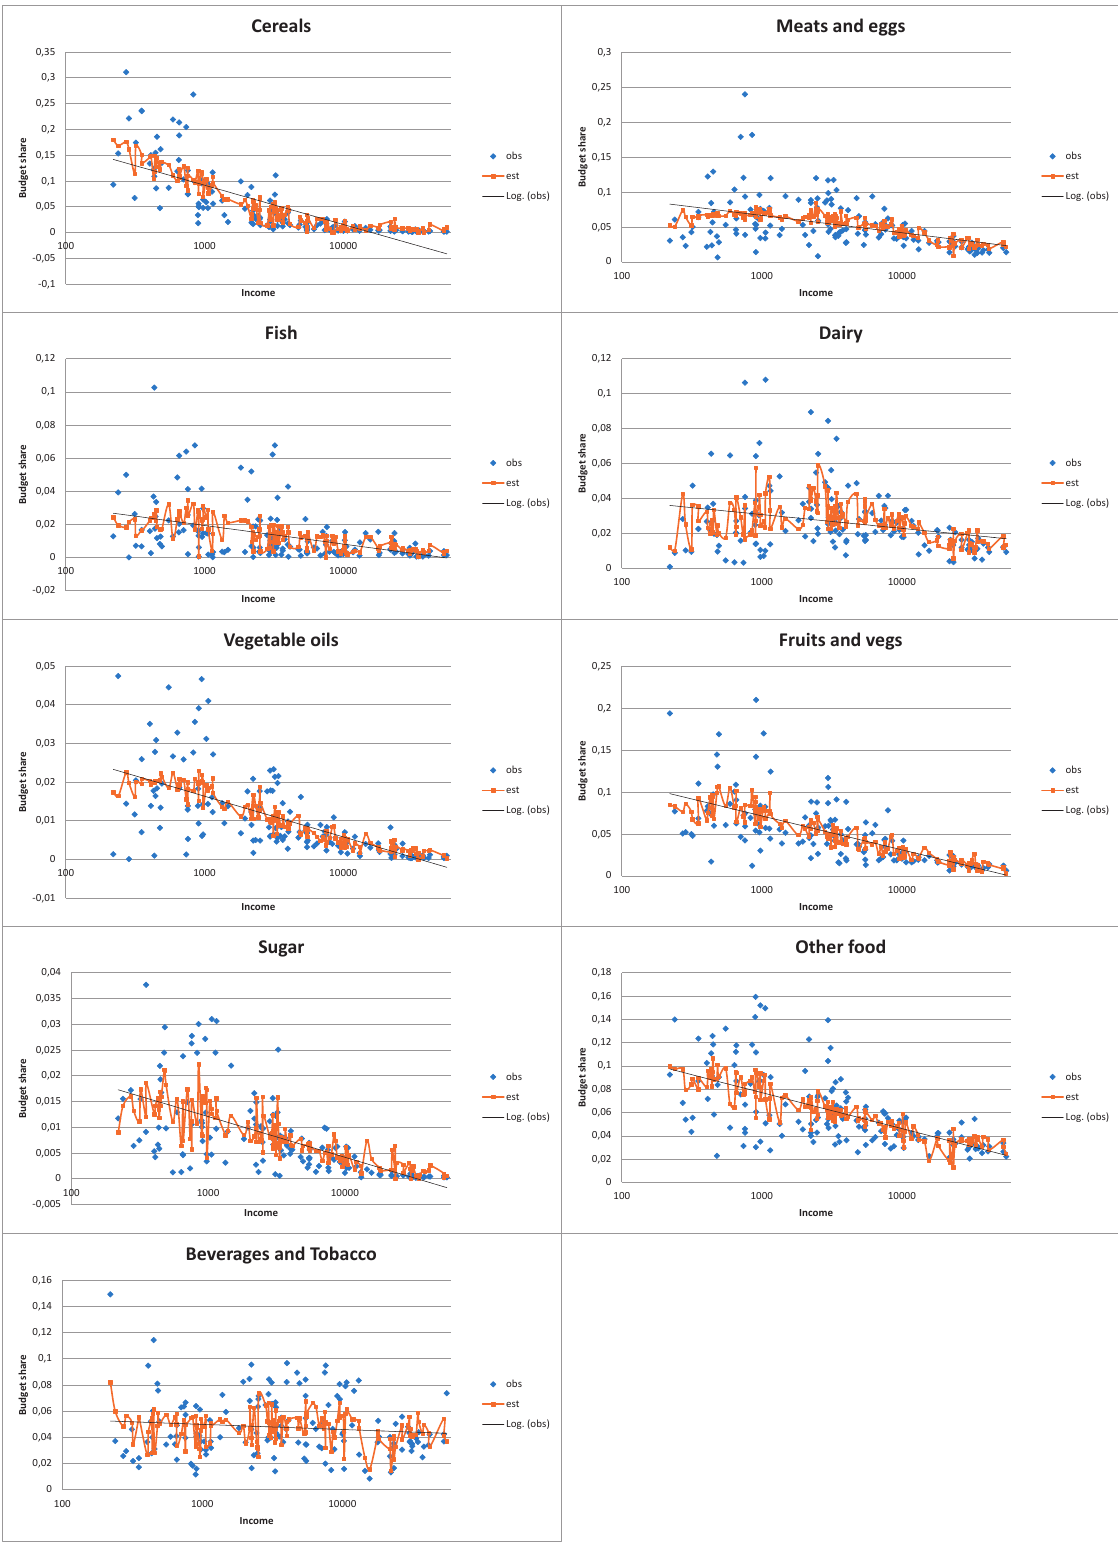
Figure 2. Scatter plots, Food